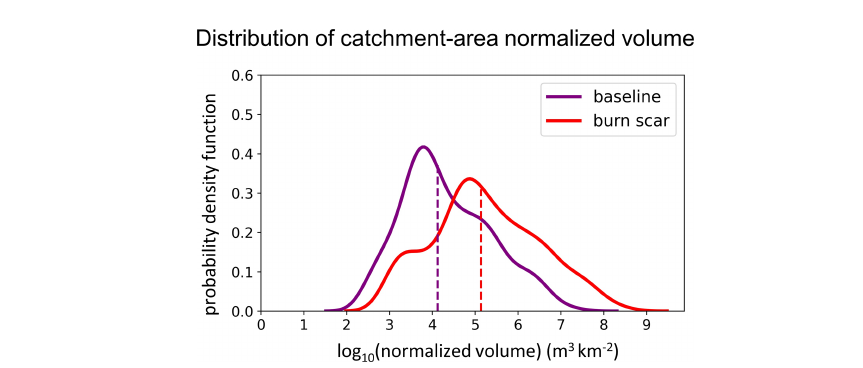
Figure B7. Distributions of accumulated discharge volumes at the outlet of the 404 catchments normalized by upstream catchment areas within the Dolan burn scar in the baseline simulation (purple line) and in the burn scar simulation (red line). Dashed vertical lines indicate median values.